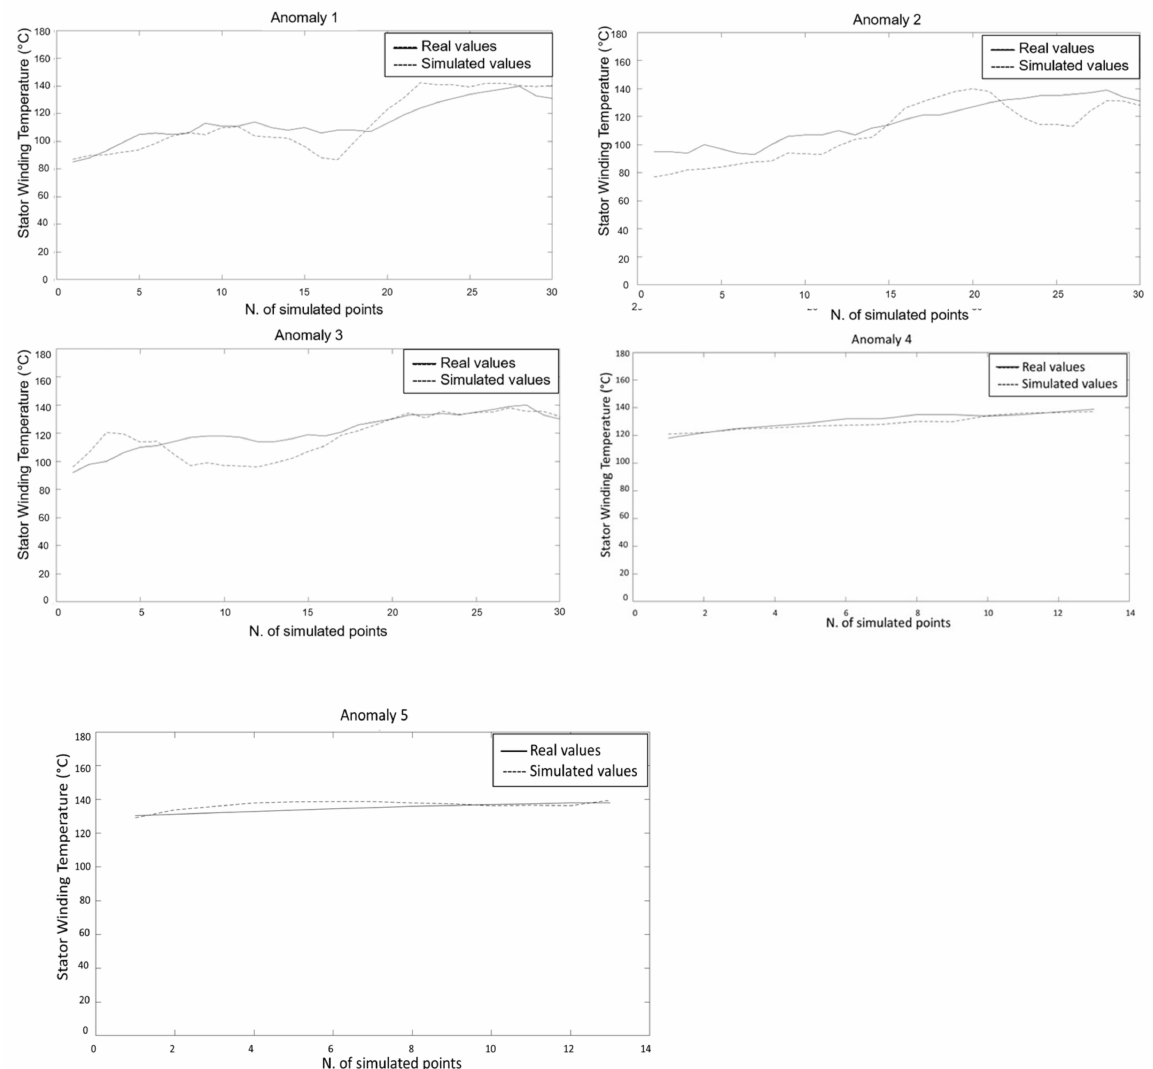
Figure 13. Temperature values during overtemperature failure-labelled